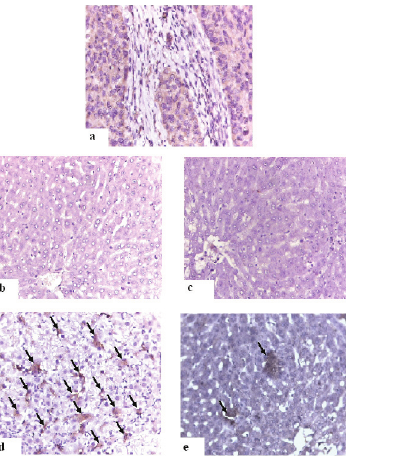
Figure 4 - Immunohistochemical expression of TNF- α . (A) Positive control for TNF- α staining in breast cancer tissue at optimum concentration of 1:100; (B) Control group; (C) Ginger extract group; (D) CDE group; and (E) CDE + ginger extract group. The arrows indicate positive staining of TNF- α (400x). OV: oval cells; H: hepatocytes; S: sinosoids; VP; vena portal